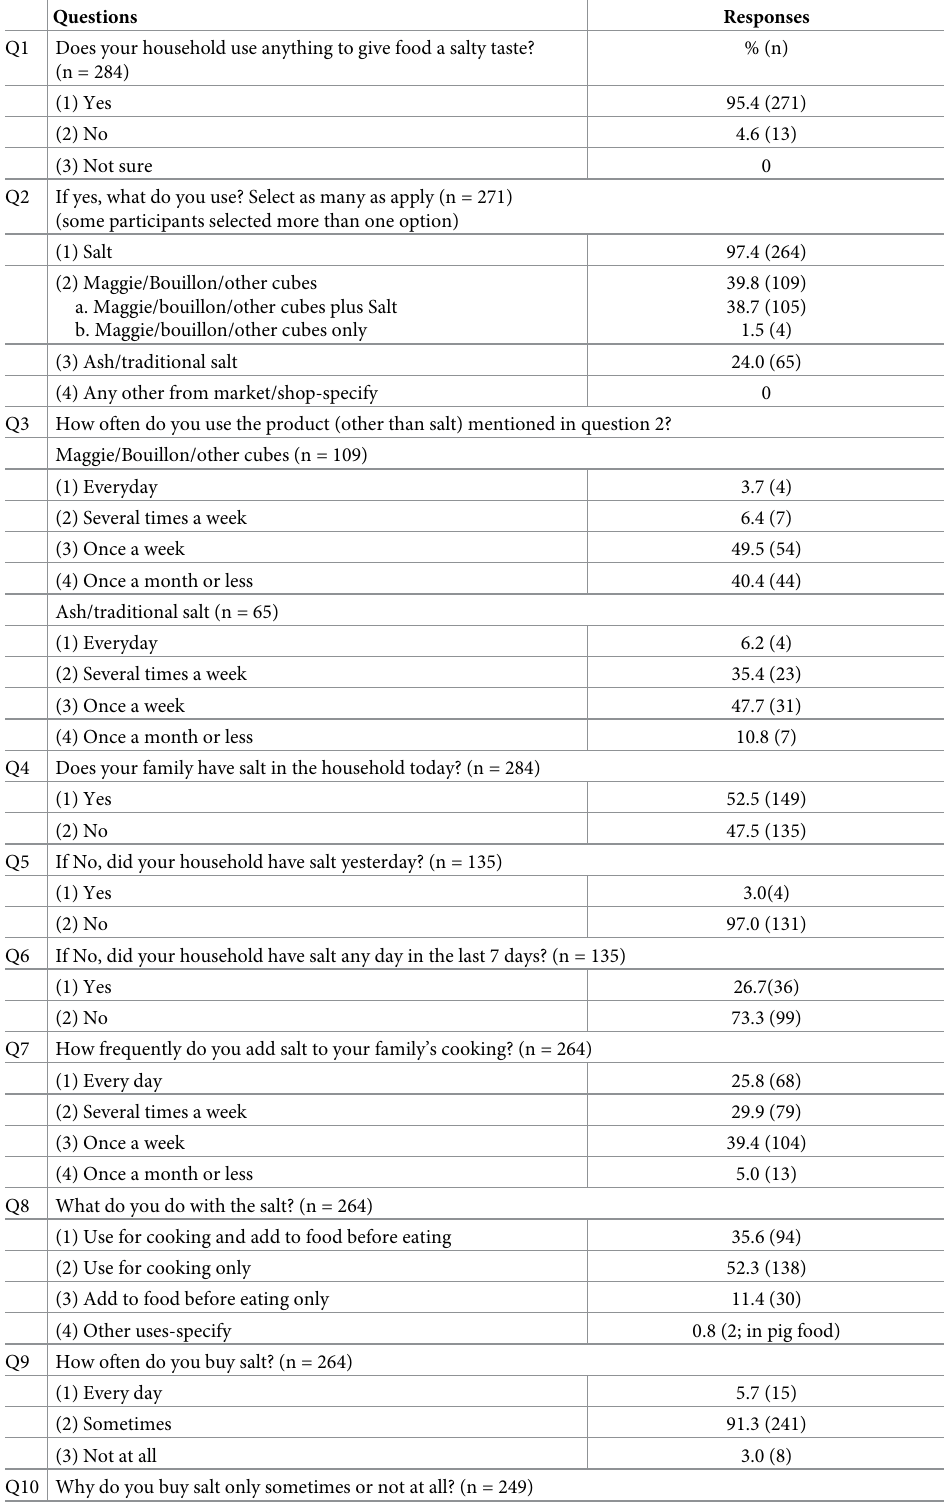
Table 3. Responses on use of salty flavourings and commercial